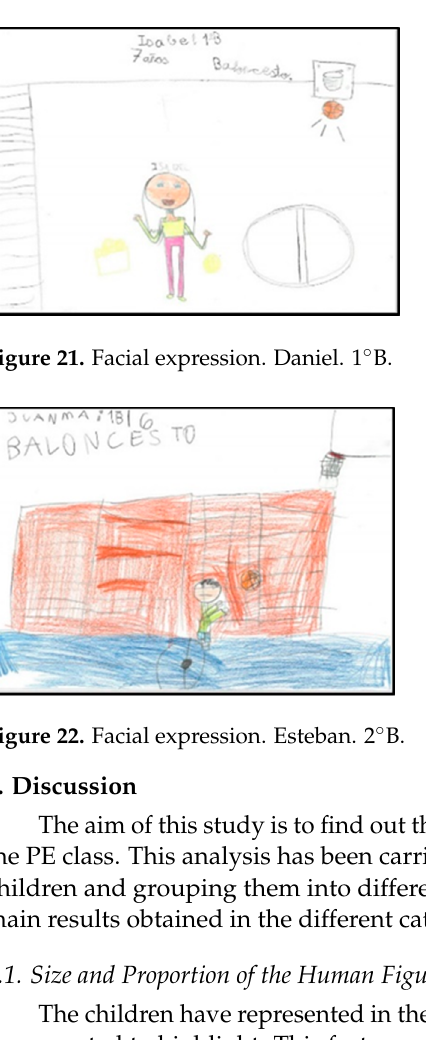
Figure 20. Facial expression. Sergio. 1°B.